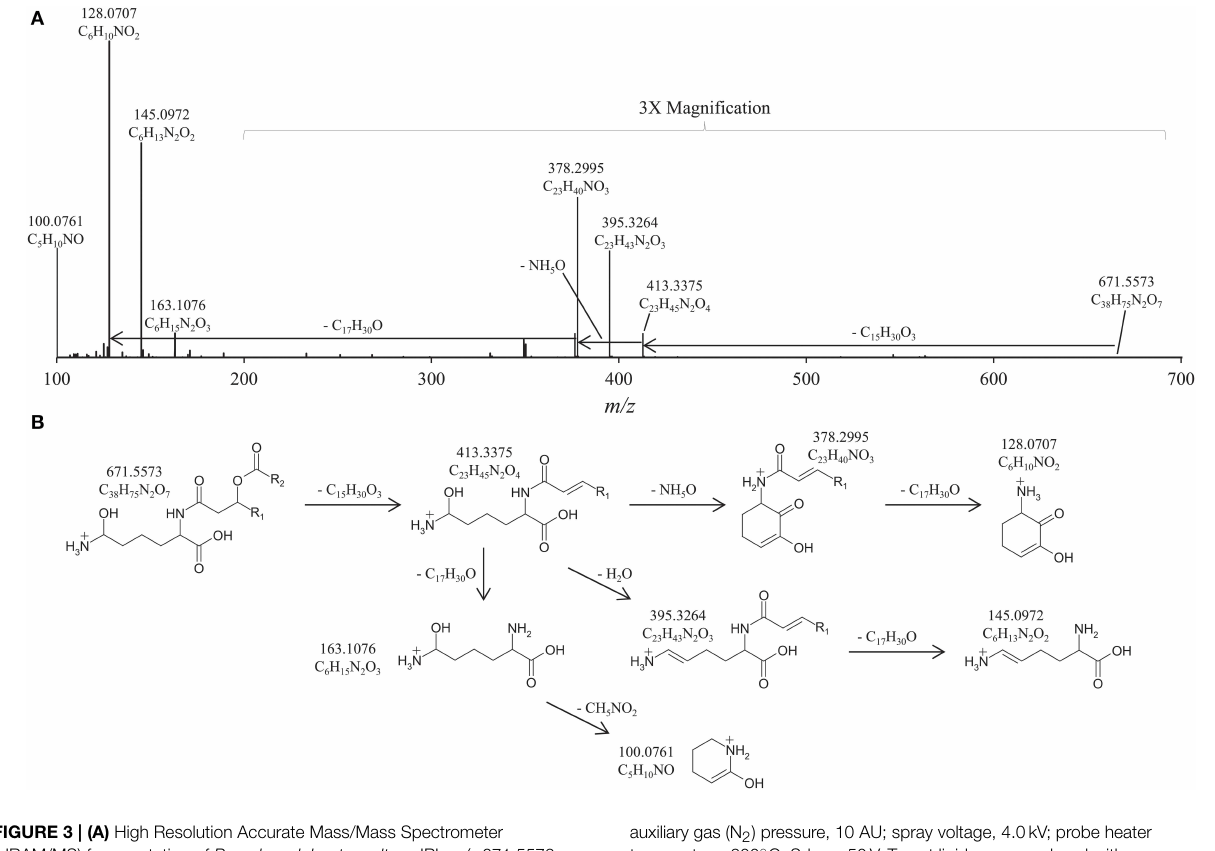
FIGURE 3 | (A) High Resolution Accurate Mass/Mass Spectrometer (HRAM/MS) fragmentation of Pseudopedobacter saltans IPL m/z 671.5573 at retention time 35.97min; (B) Proposed MS fragmentation of IPL with hydroxylysine head group (HLL). The relative abundance of the m/z 200–700 range is magnified 3 × . The positive-ion ESI settings were as follows: capillary temperature, 275 ◦ C; sheath gas (N 2 ) pressure, 35 arbitrary units (AU);